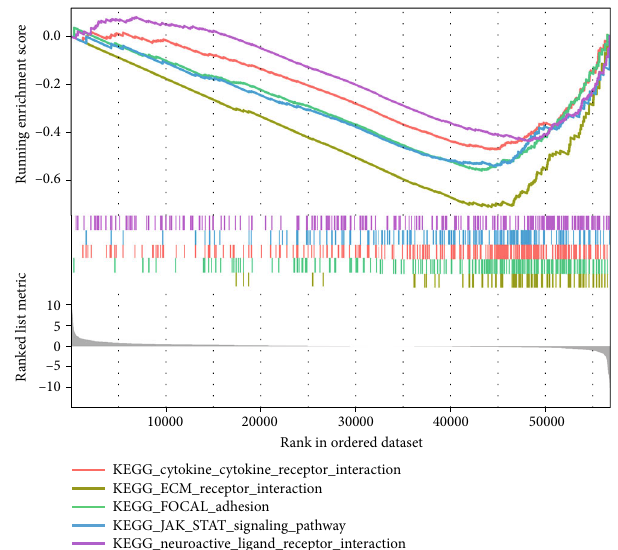
Figure 8: GSEA enrichment analysis of COX7B expression in ESCA patients from TCGA datasets.